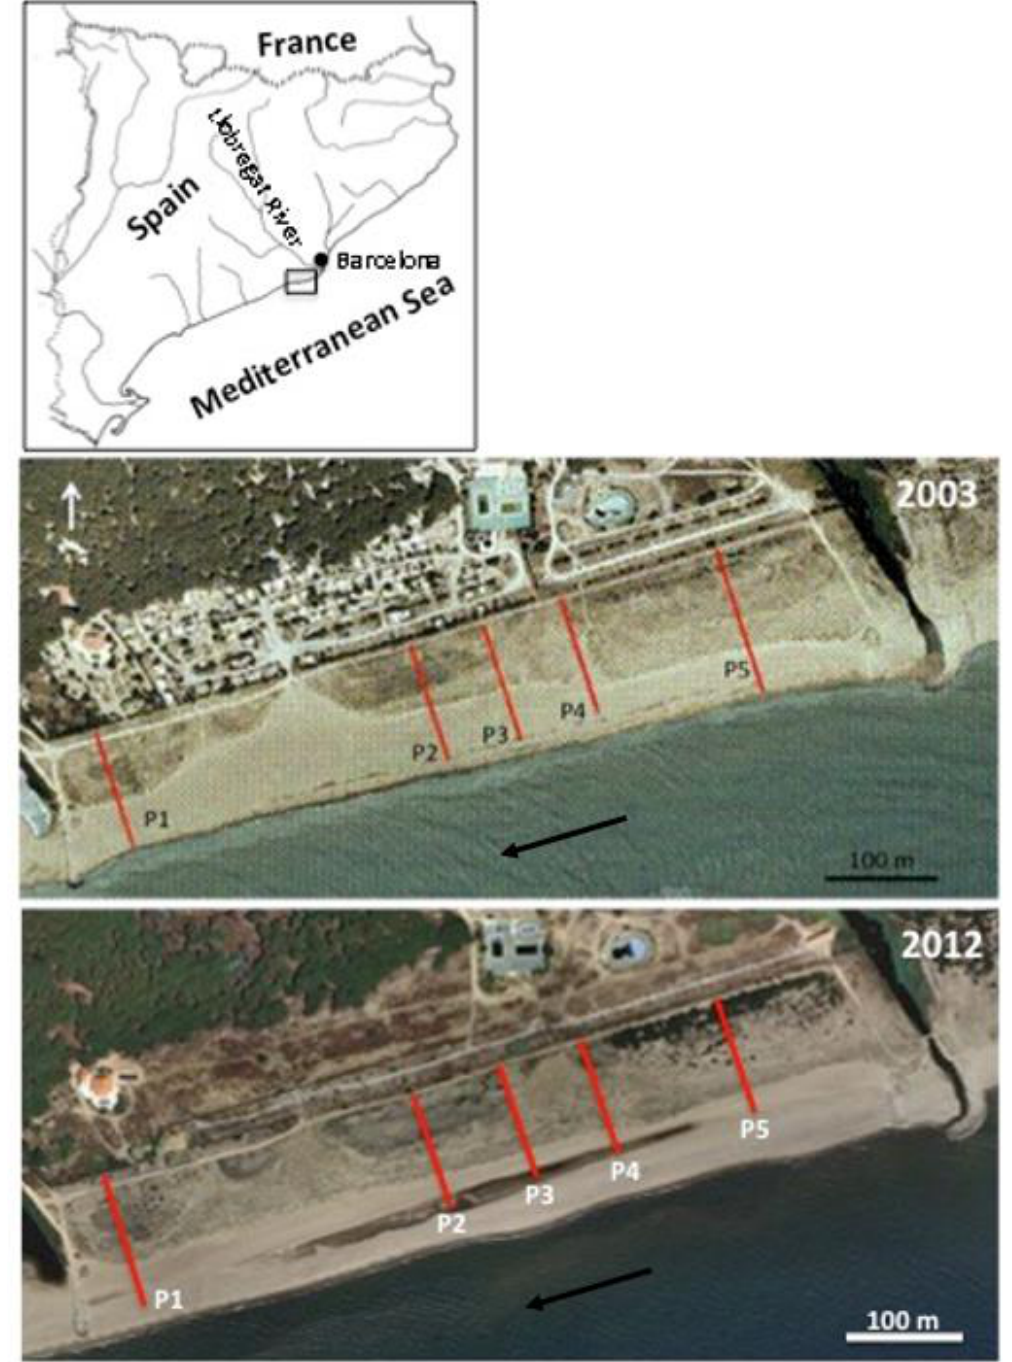
Figure 1. Location of the study area, box south of the Llobregat River and aerial view of the beach of Remolar in years 2003 and 2013 (http://www.icc.cat/vissir3/). The regression of the dune system in 2003 is evidenced, mainly due to the trampling on the dunes. On this view, the red lines (P1 to P5) indicate the topographic and vegetation profiles; grain-size distribution analysis was performed in P1 and P5, and ground-penetrating radar (GPR) profiles were realized in P1 and P2. The 2013 photo shows how both the morphology of the dune zone and the vegetation in the area have increased and stabilized. The black arrow, south of the coastline, indicates the predominant direction of the coastal drift at Remolar beach, in the ENE-WSW direction.